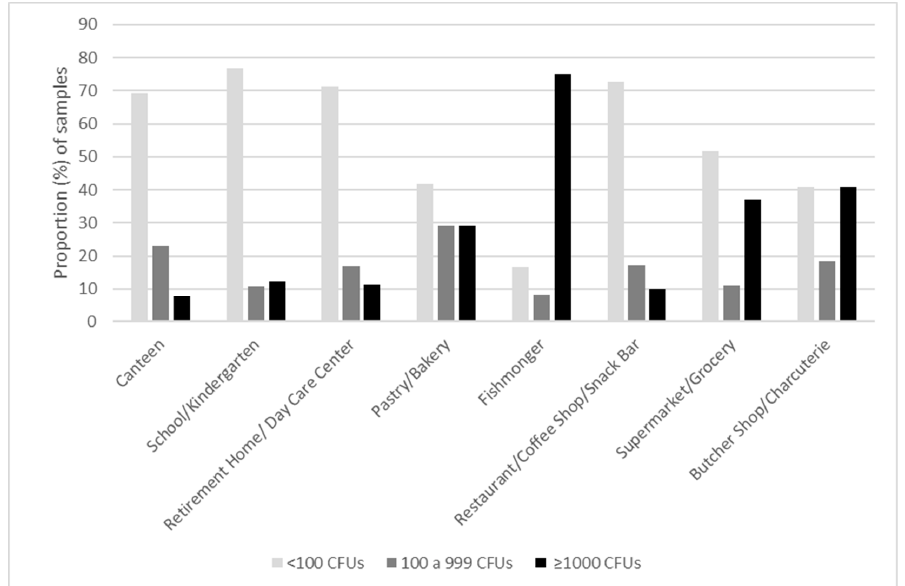
Figure 2. Proportion of samples taken from kitchen utensils/crockery according to the number of CFUs of mesophilic microorganisms at 30 °C per swab/plate.